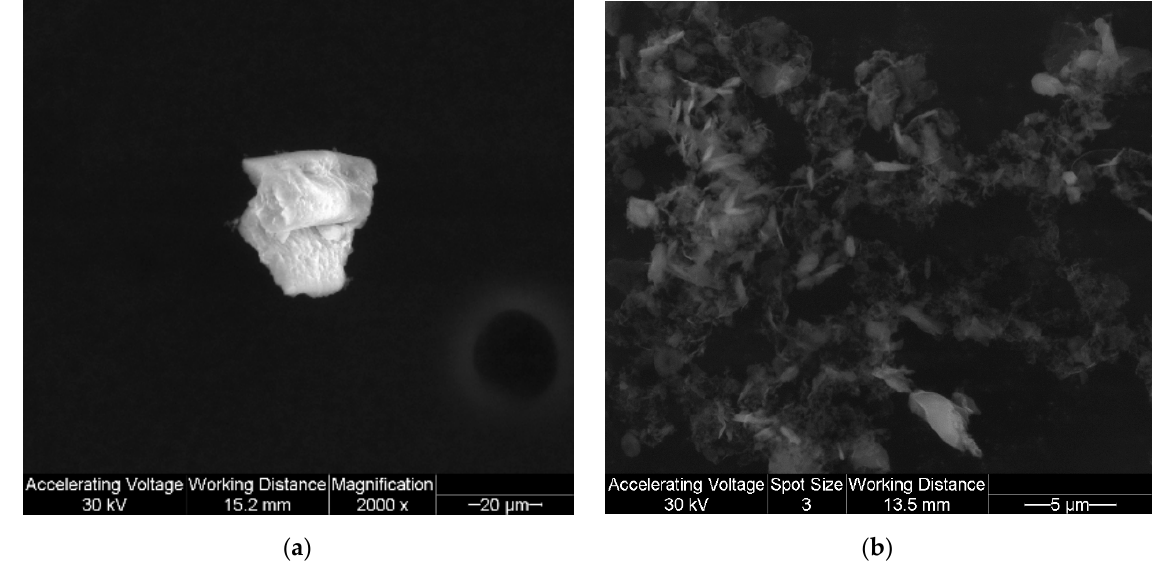
Antioxidants 2021 , 10 , x FOR PEER REVIEW Figure 2. Scanning electron micrographs of: ( a ). raw TMP (magnification 2000×) and ( b ). SD TMP (magnification Figure 2. Scanning electron micrographs of: ( a ). raw TMP (magnification 2000 × ) and ( b ). SD TMP (magnification 10,000 × ). 10,000×).